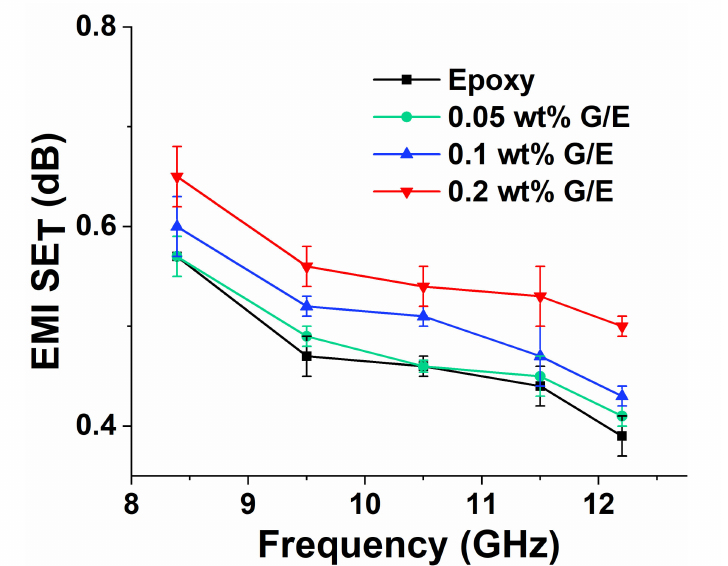
Figure 16. Total EMI shielding effectiveness values of pristine epoxy and different GO